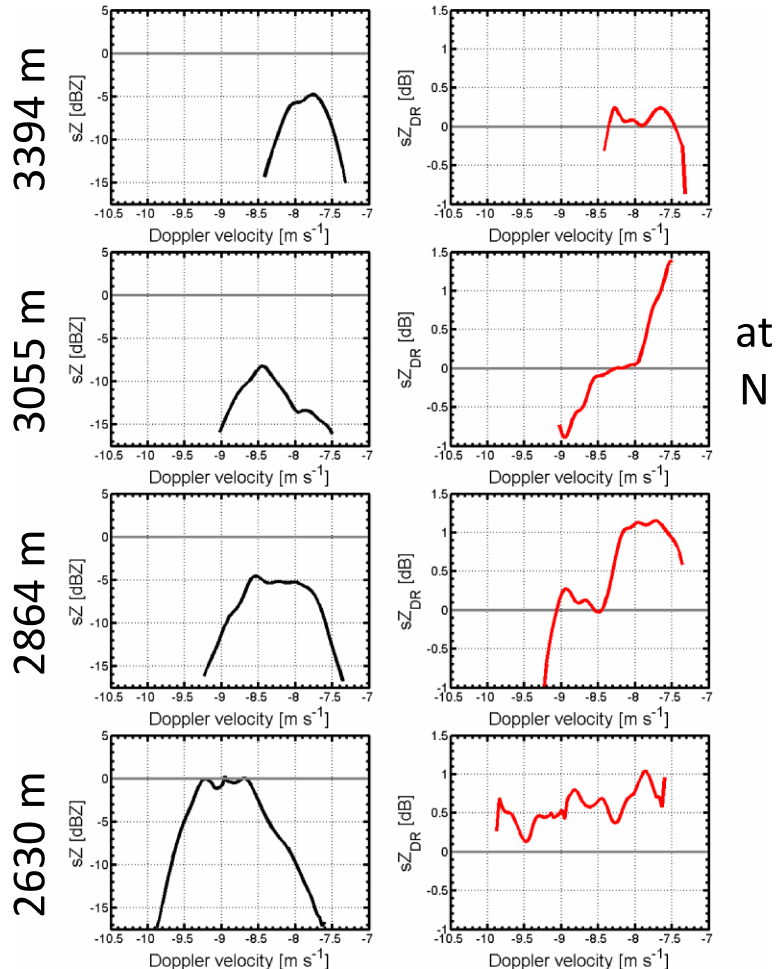
Figure 11. Along the fall streak at 11:33:31UTC rearranged sZ and sZ DR at four different altitudes. The left panel shows Doppler spectra at 3394, 3055, 2864, and 2630m. The right column displays the corresponding spectral differential reflectivity at the same heights. All spectra are at 45 ◦ elevation and averaged over 3 consecutive time bins ( ∼